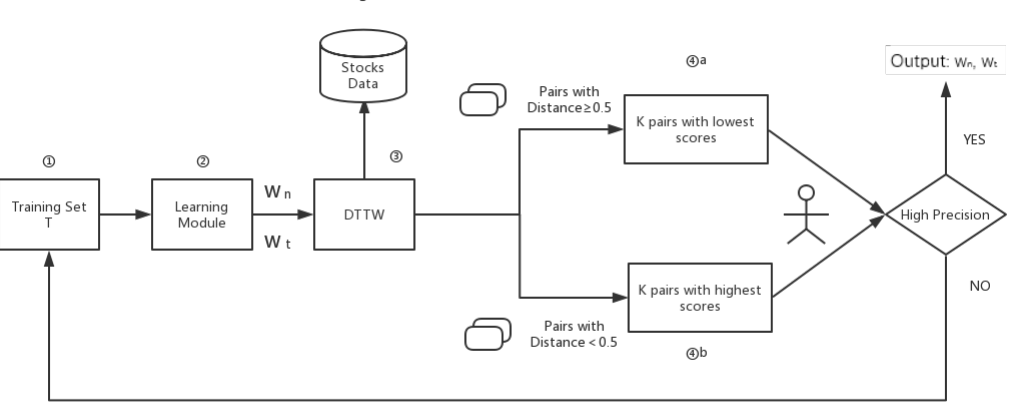
Figure 5. Overview for the active learning